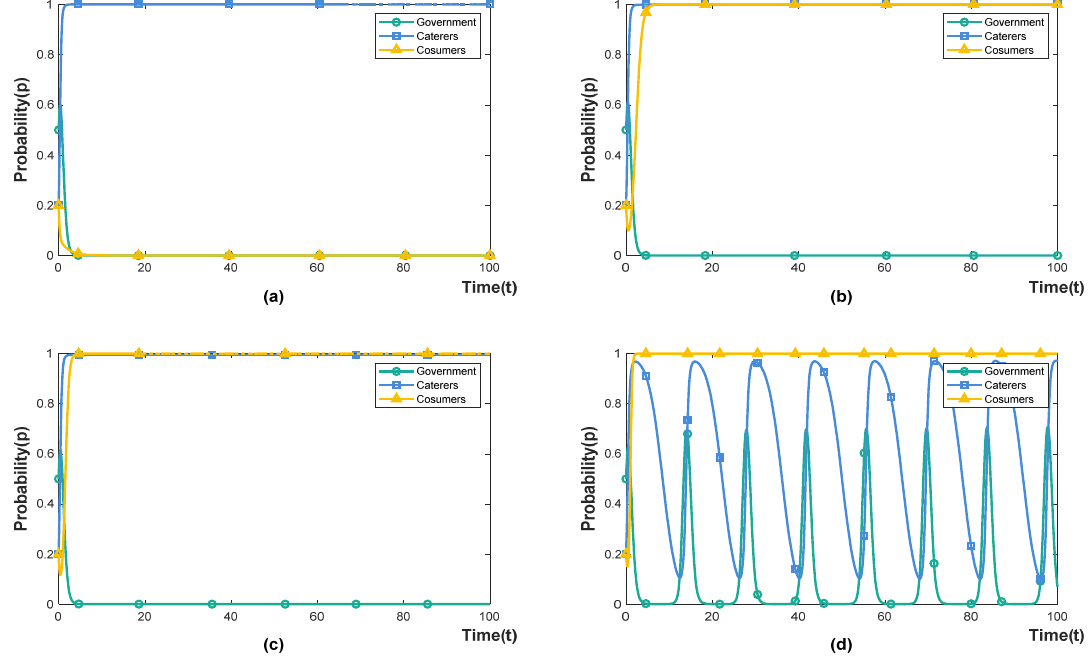
Figure 4. The effect of μ on the evolution trajectory. ( a ) 𝜇 = 0.2 . ( b ) 𝜇 = 0.4 . ( c ) 𝜇 = 0.6 . ( d ) 𝜇 = 0.8 .